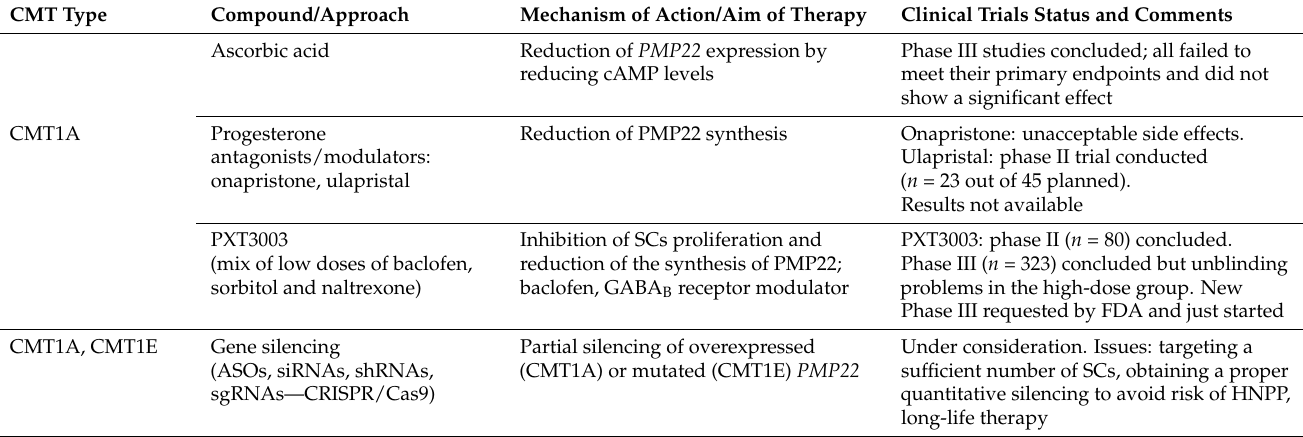
Table 1. Main therapeutic approaches and compounds under study for Charcot-Marie-Tooth disease and related neuropathies. CMT